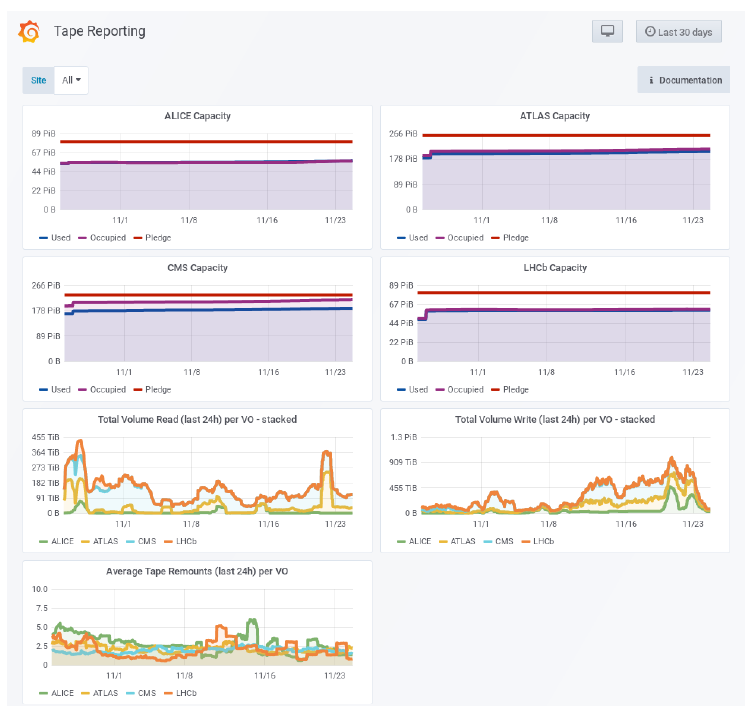
Figure 4. The tape-specific dashboard exposes additional metrics that are relevant to the tape